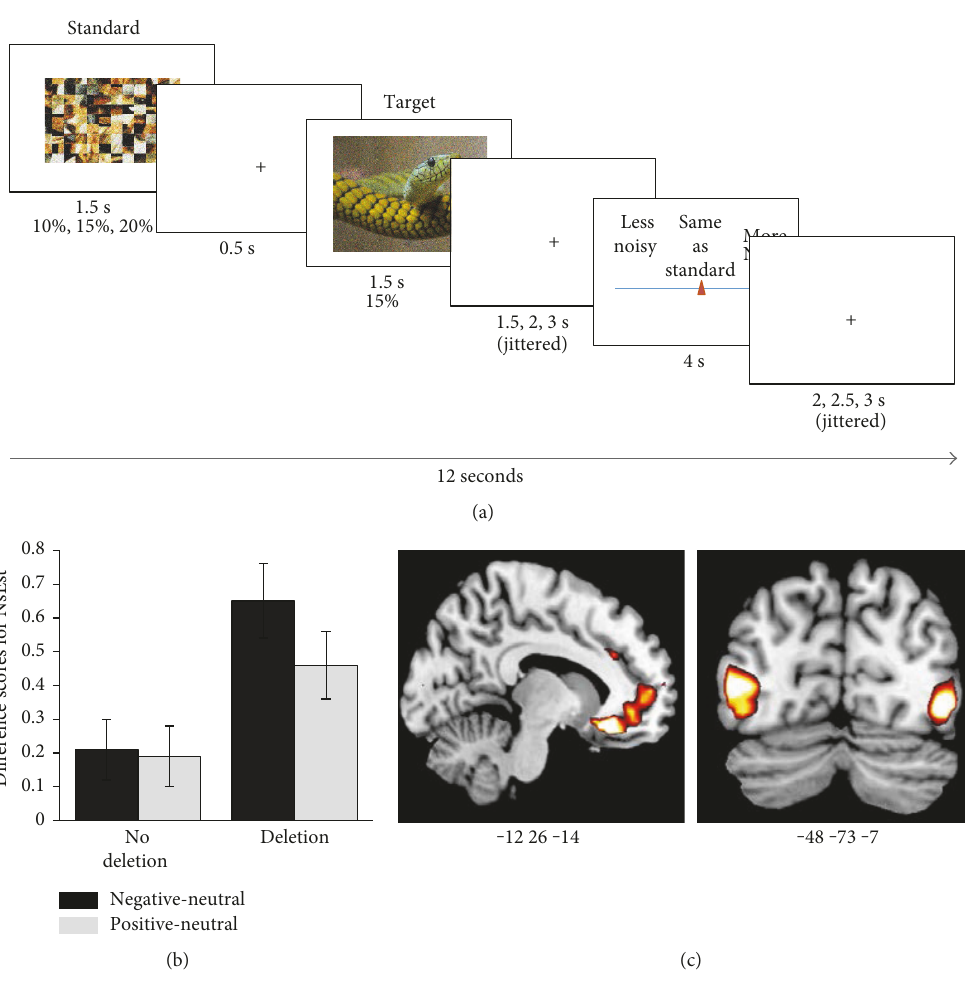
Figure 4: (a) Noise Estimation task to determine emotionally enhanced vividness (EEV). A standard (scrambled image) was overlaid with varying levels of noise. The standard was followed by the target overlaid with 15% noise. Participants were asked to indicate whether the target had more or less noise relative to the standard. (b) Di ff erence scores for ratings of inverse noise estimation (NsEst − 1 ), a measure of perceptual vividness for negative and positive > neutral stimuli in noncarriers and carriers of the ADRA2b deletion variant. Deletion carriers show greater EEV than noncarriers. (c) Statistical maps showing parametric modulation by EEV in the ventromedial prefrontal cortex for ADRA2b carriers > noncarriers and in the lateral occipital complex showing modulation by EEV across both groups. Adapted with permission from “ Neurogenetic variations in norepinephrine availability enhance perceptual vividness ” by Todd et al. [40]. Copyright 2015 by the Society for